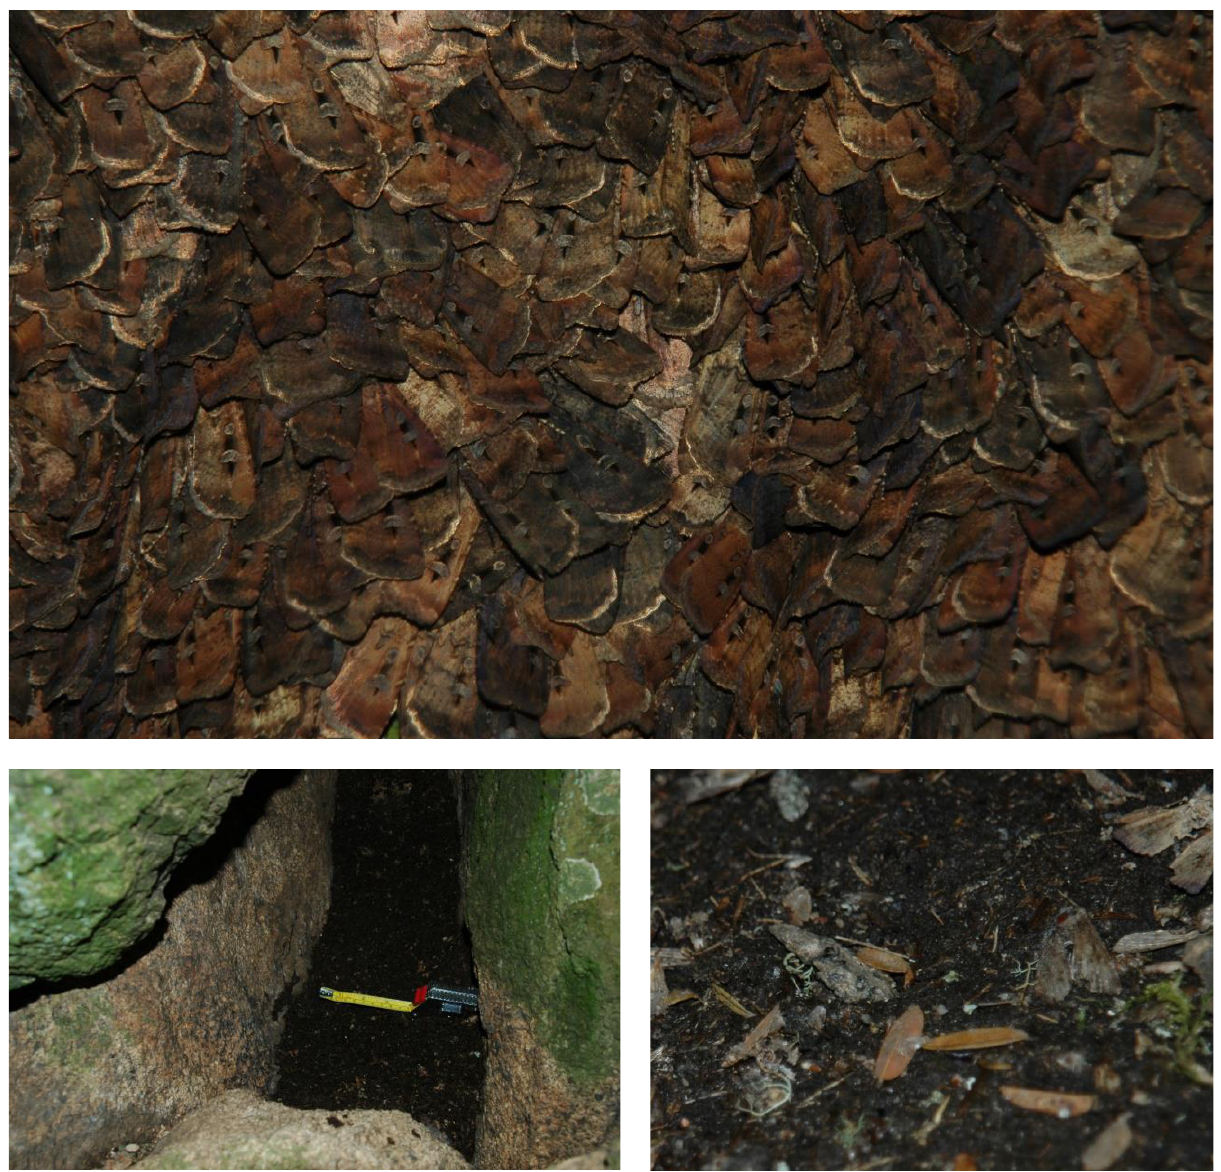
Figure 1. Above: aestivating Bogong moths ( Agrotis infusa ). Below left: peaty deposit in a crevice between rocks (at Bogong Peaks). Below right: Surface of a peaty deposit (at Gingera Big Cave) showing remains of A. infusa , leaves of the mountain plum-pine Podocarpus lawrencei , lichen filaments and twigs. Bogong moths can be found hiding in complex boulder piles, scree-slopes, rock-shelters and caves (Figure